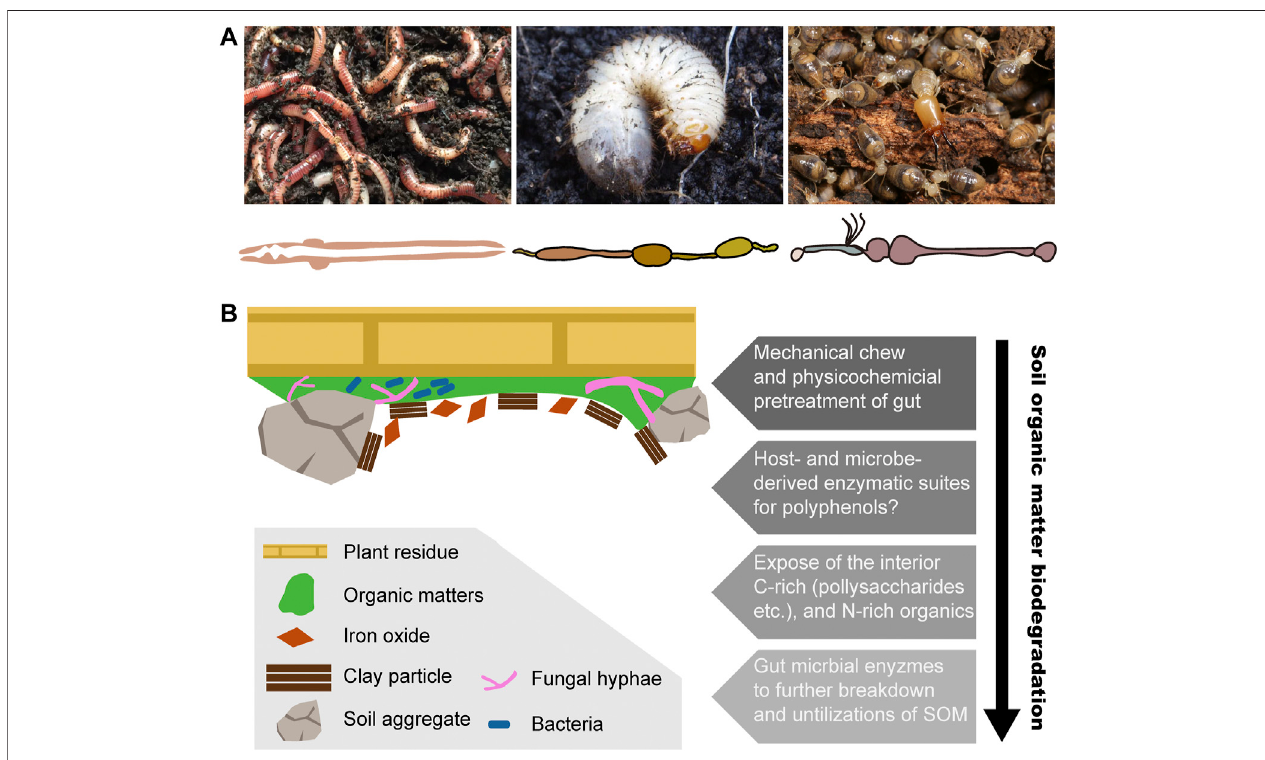
FIGURE 2 | Biodegradation process ofsoil organic matter in three representative humivorous fauna. (A) Humivorous earthworm, beetle larva, and higher termites, as well as their gut morphology. Termite photo image courtesy of Jan Š obotn ĺ k. (B) Structural complex and heterogeneity of soil organic matter and the hypothetical biodegradation mechanism among soil-feeding